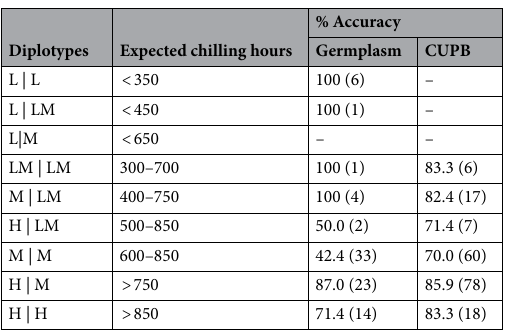
Table 4. Comparison between actual and predicted chill hour requirements obtained from Ppe.CR.1 assay in the U.S. germplasm and the Clemson University Peach Breeding (CUPB) program. Numbers in parenthesis indicate the number of individuals with this